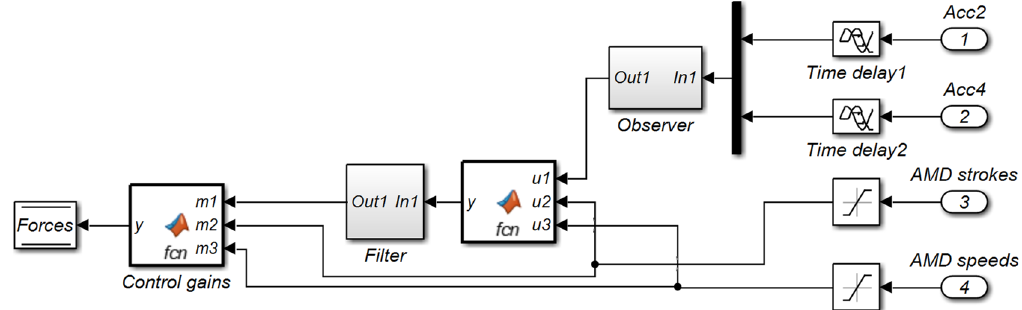
Figure 10. The Simulink diagram of the experimental system. Table 3. The control effects under the numerical results (mean square values).